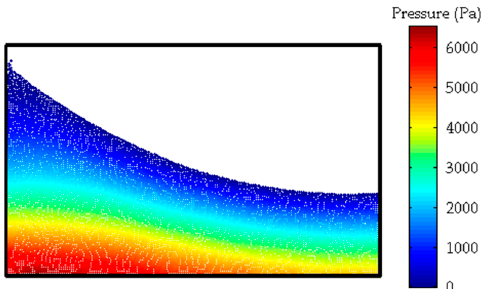
Figure 26. Flow pattern and pressure distribution in the SPH simulation without the baffle ( h = 1.33 ∆ x , ∆ x = 0.01 m )